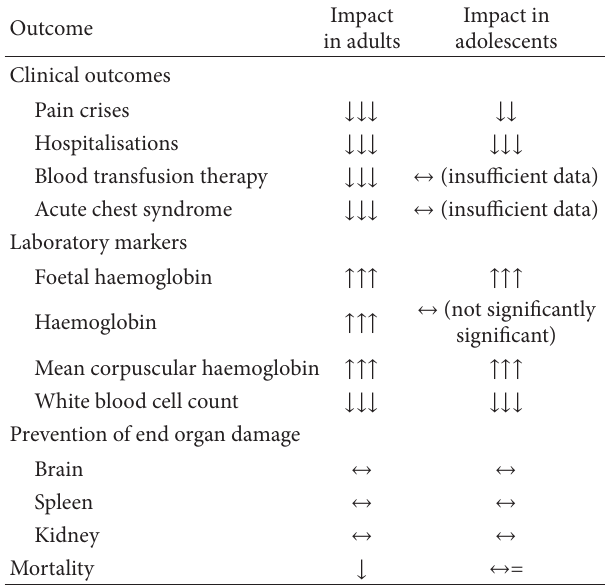
Table 3: Summary of study outcomes for hydroxyurea use in adults and